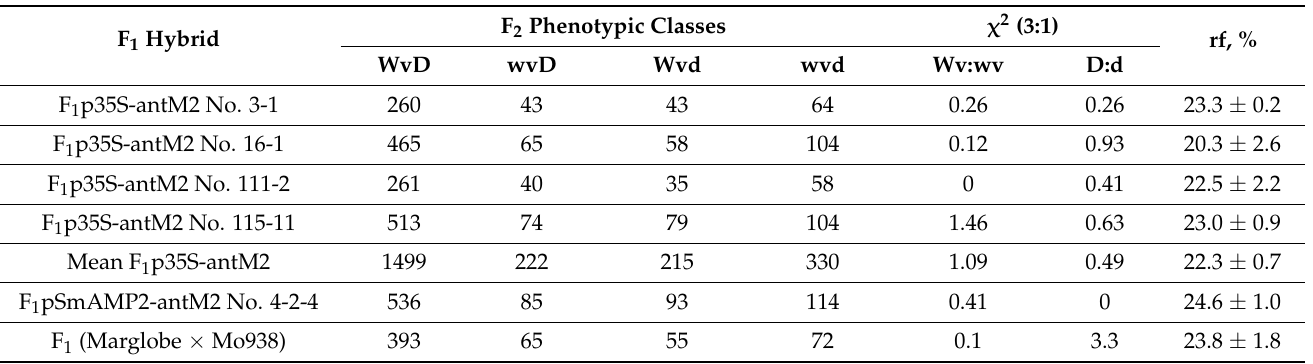
Table 2. Frequency of meiotic recombination (mean ± SD) between marker genes wv and d of chromosome 2 in tomato F 1 hybrids with MSH2 silencing by RNAi under “short-day”